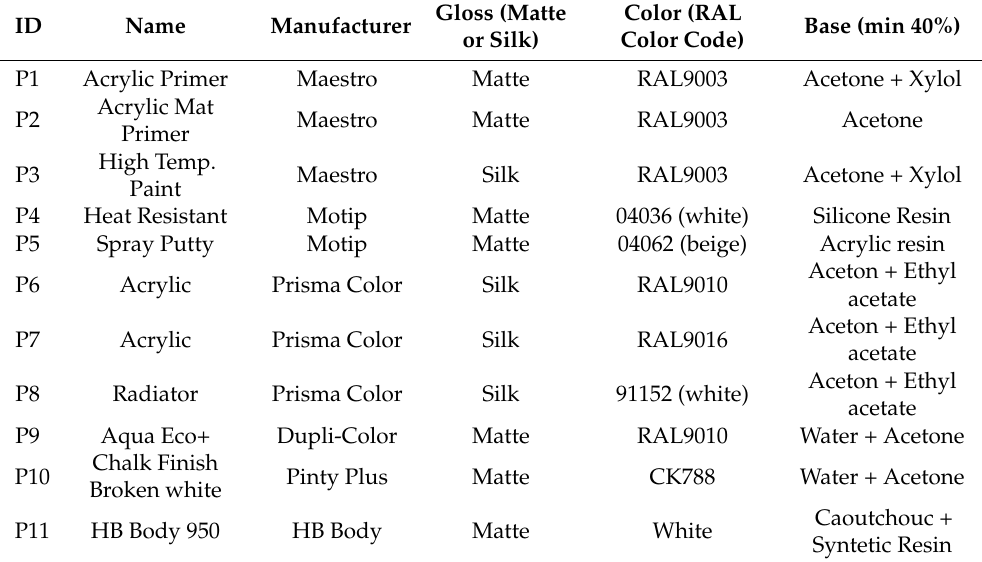
Table 2. List of the applied